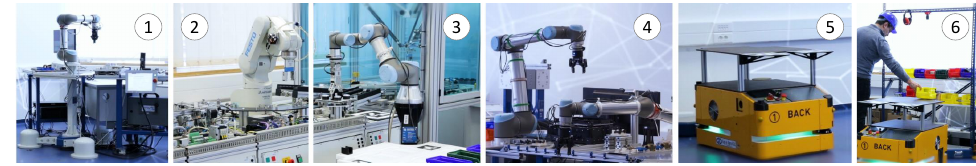
Figure 8. Physical components of the CPSs in the demonstrated use